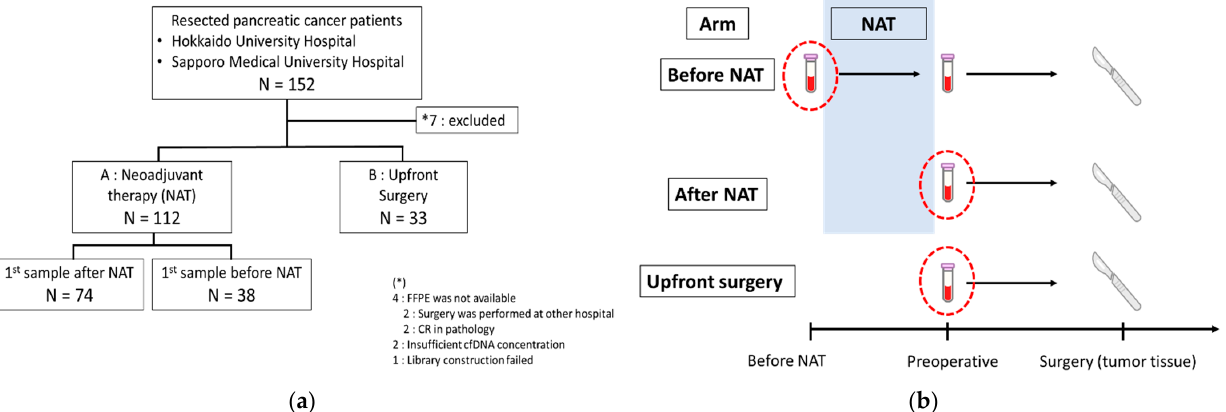
Figure 1. Patient enrollment and sample collection. ( a ) The consort flow diagram of patient recruit- ment; ( b ) sample collection timepoints of 3 different subgroups. Table 1. Clinical characteristics of 145 pancreatic cancer patients.